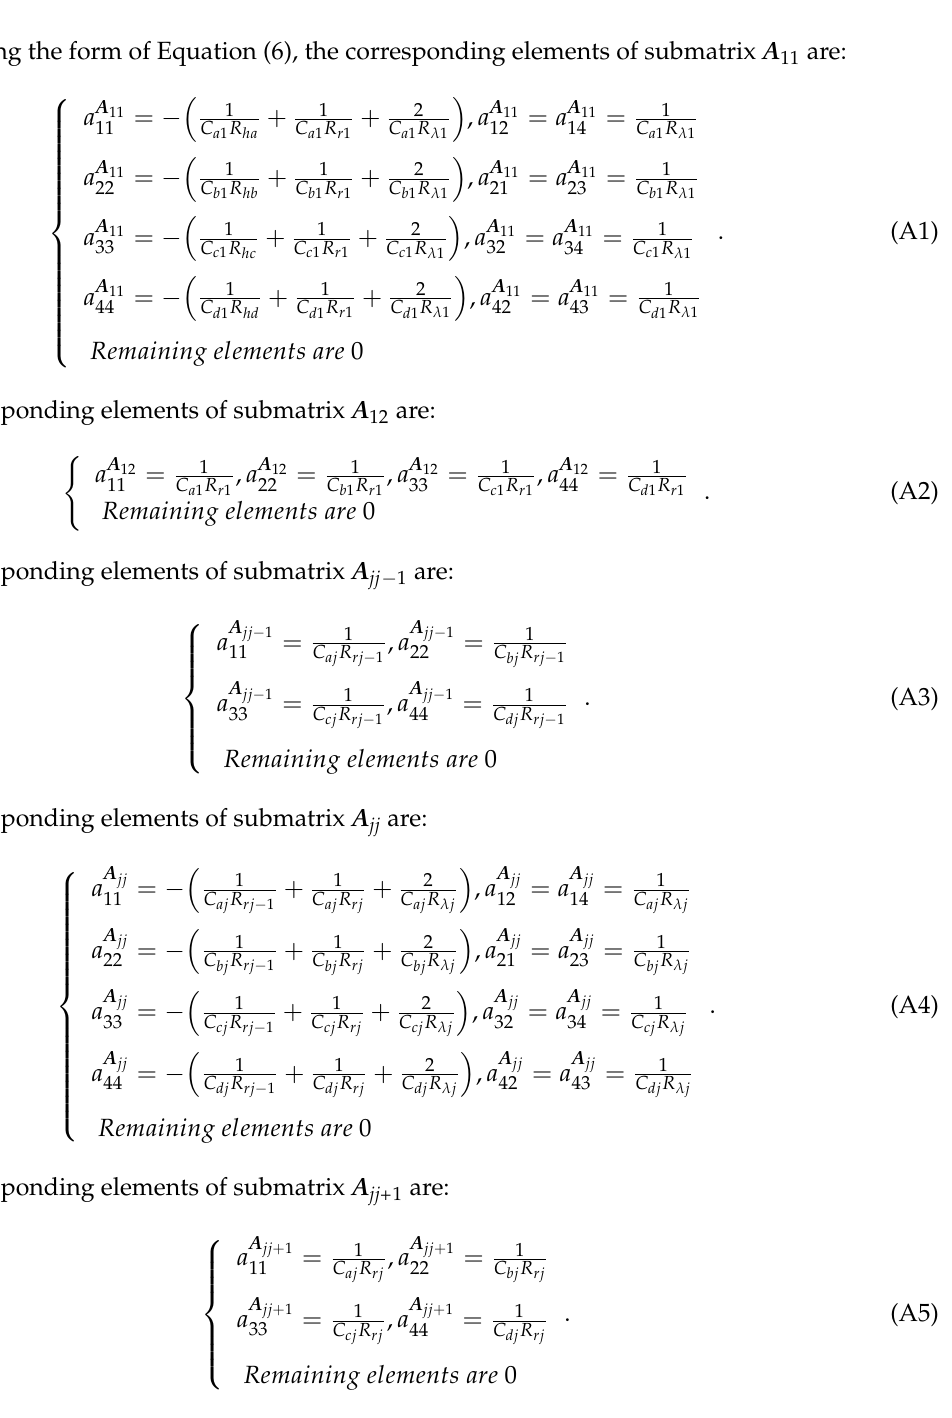
Table A1 show that the main parameters of the experimental equipment in temperature rise test platform. Table A2 show that the main parameters of ACSR LGJ400/35